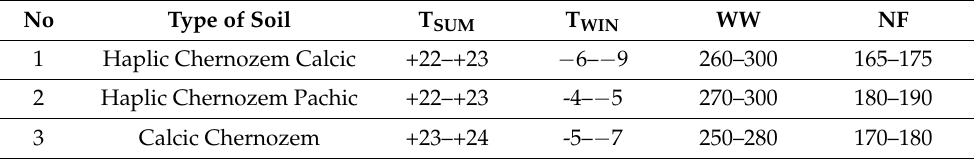
Table 2. Average annual rainfall and soil